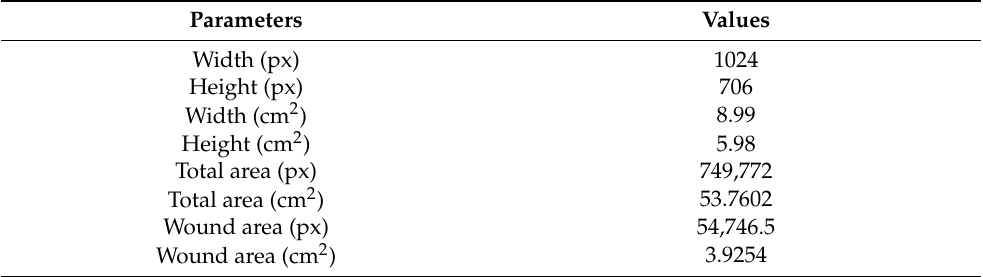
Table 2. Final measured values.